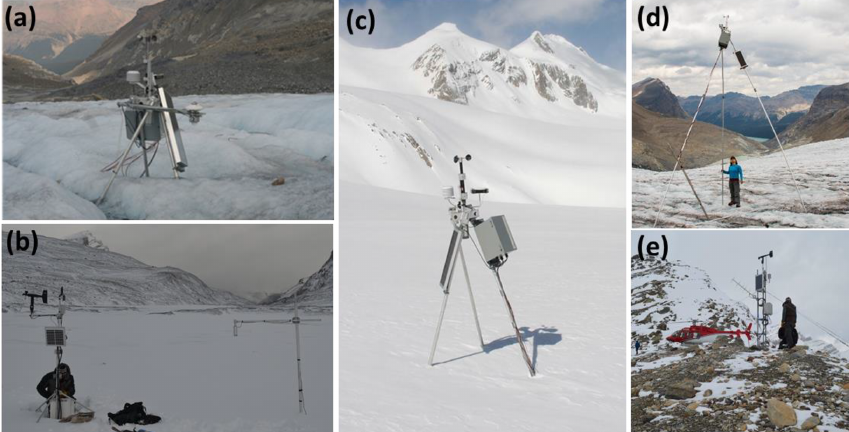
Figure 3. Photographs of selected CryoNet stations in the PGRB. (a) Peyto Lower Ice (2009), (b) Peyto Lower Ice (October 2016), (c) Peyto Middle Ice (April 2006), (d) Peyto Middle Ice (September 2015) and (e) Bow Hut (October 2016). Photographs by Dhiraj Pradhananga (b, e) , D. Scott Munro (a, c) and Angus Duncan (d)